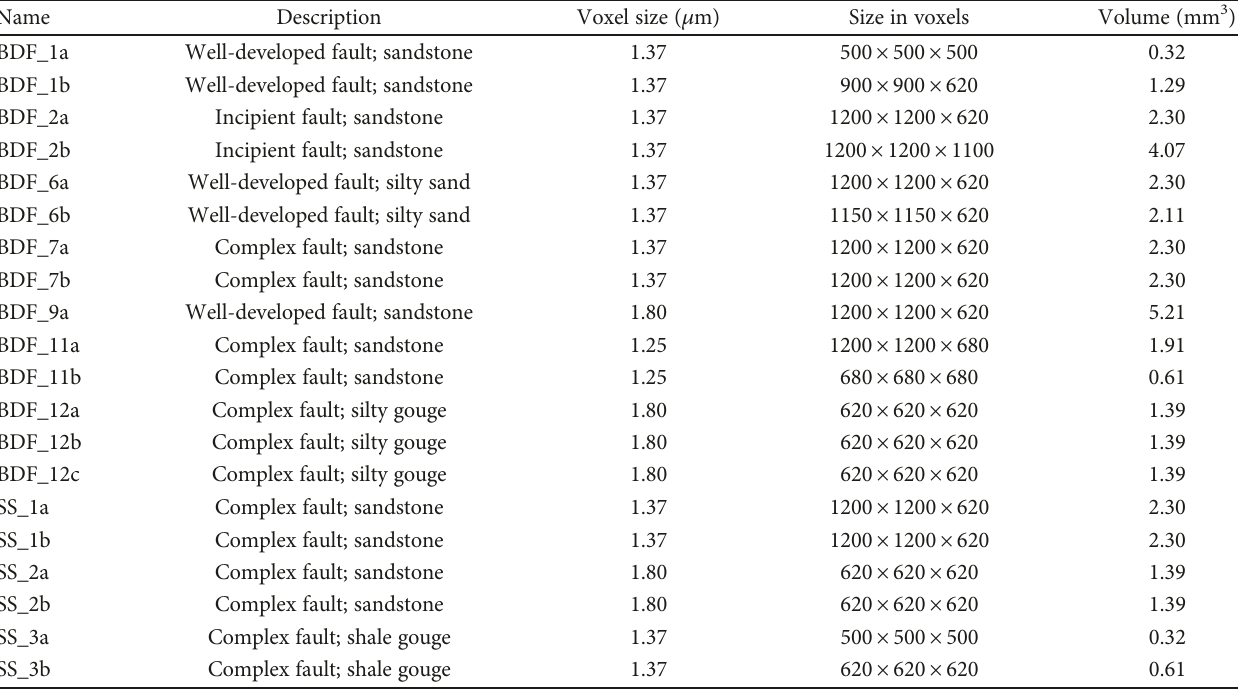
Table 2: Volumes of interest